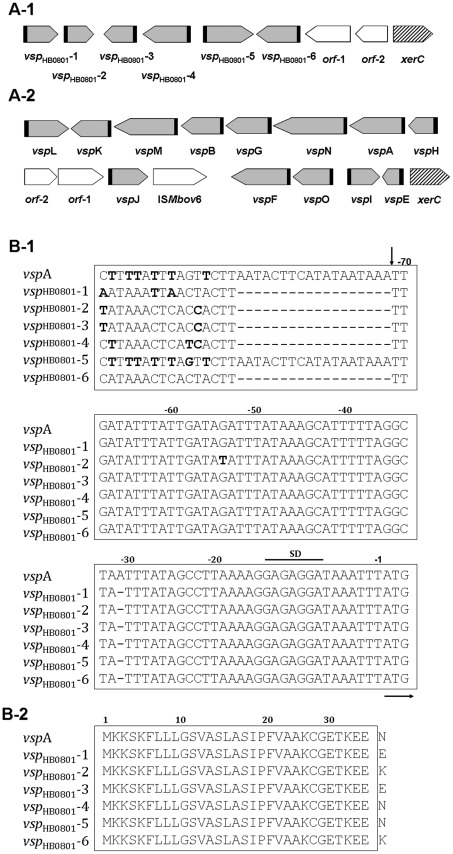
Comparison of vsp Gene Cluster between M. bovis HB0801 and PG45.The vsp gene loci of HB0801 (A-1) and PG45 (A-2) are shown. The locations and directions of the vsp ORFs are indicated with gray arrows. The adjacent non-vsp ORFs (ORF-1 and ORF-2) are indicated with open arrows. The locations of the putative tyrosine recombinase genes (xer C) are indicated with hatched arrows. The highly homologous regions upstream of the vsp genes are indicated with black blocks. (B) Sequence alignments for vsp upstream 5′ regions (B-1) and Vsp N-terminal regions (B-2). The HB0801 vsp gene family (vsp
HB0801-1 to -6) and the vspA gene, a representative PG45 vsp gene, are compared. The numbers above the sequences indicate positions relative to the initiation codon. Nucleotides representing a putative ribosome-binding site (SD) are headlined and the initiation codon (ATG) is underlined with a horizontal arrow. The division of the vsp upstream 5′ region into two distinct cassettes is indicated by a vertical arrow at nucleotide position -72.